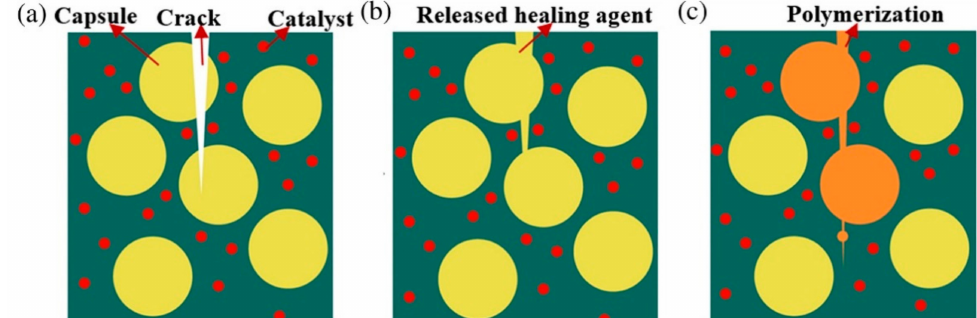
Figure 12. Self-healing schematic concept for cementitious materials that are ( a ) crack forming, ( b ) healing agent releasing, and in ( c ) polymerization with catalysts [98]. Images obtained with permission from C. Xue, W. Li, J. Li, V.W.Y. Tam, and G. Ye, “A review study on encapsulation-based self-healing for cementitious materials,” Struct. Concr., vol. 20, no. 1, pp. 198–212,